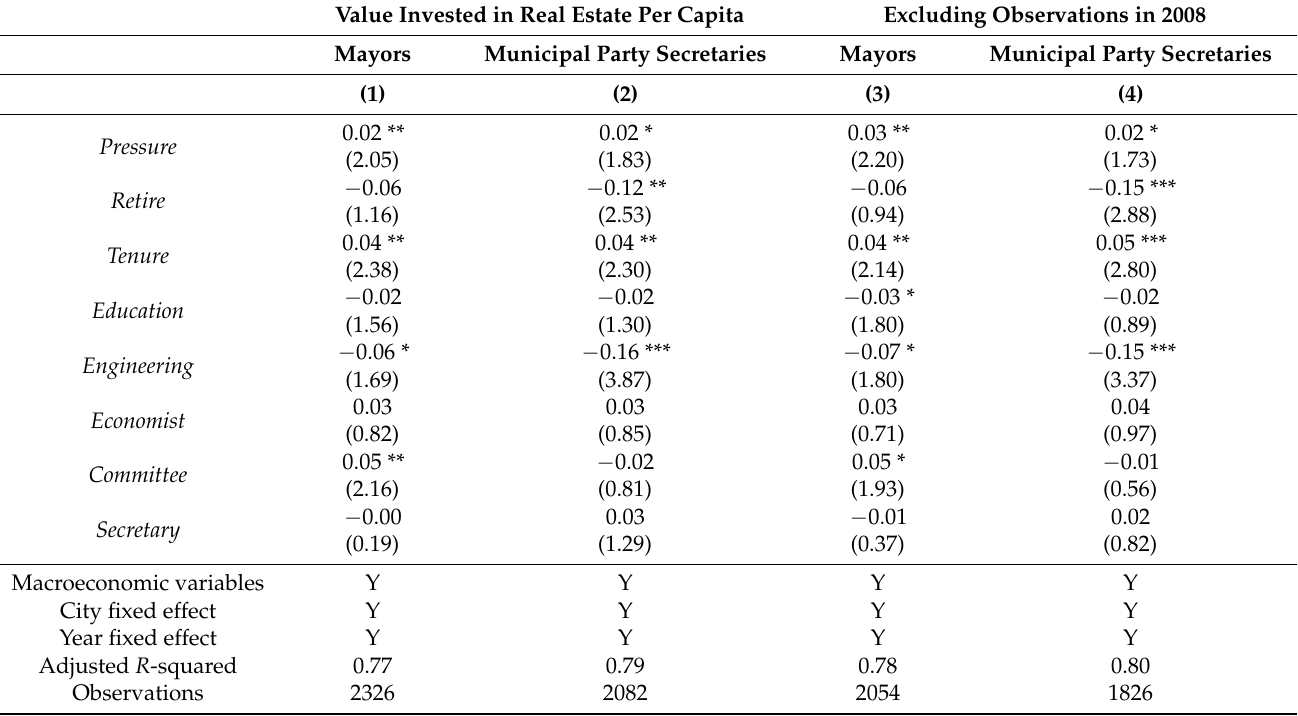
Table 3. Results of robustness